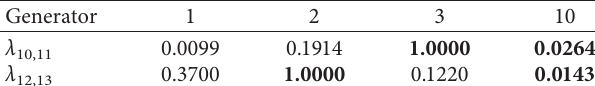
Table 3: Components of the participation vector corresponding to the rotation speed of each